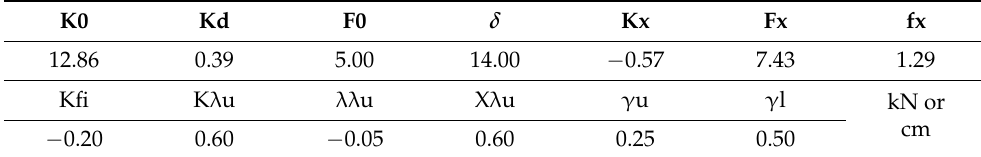
the parameters of the hysteretic model per wall (width: 910 mm) are shown in Tables 2 and 3, respectively. The repetition experiment results and calculation values are shown in Figures 9 and 10, respectively. The red line in the figure shows the backbone curve. Table 2. Set parameters of plywood walls per wall.